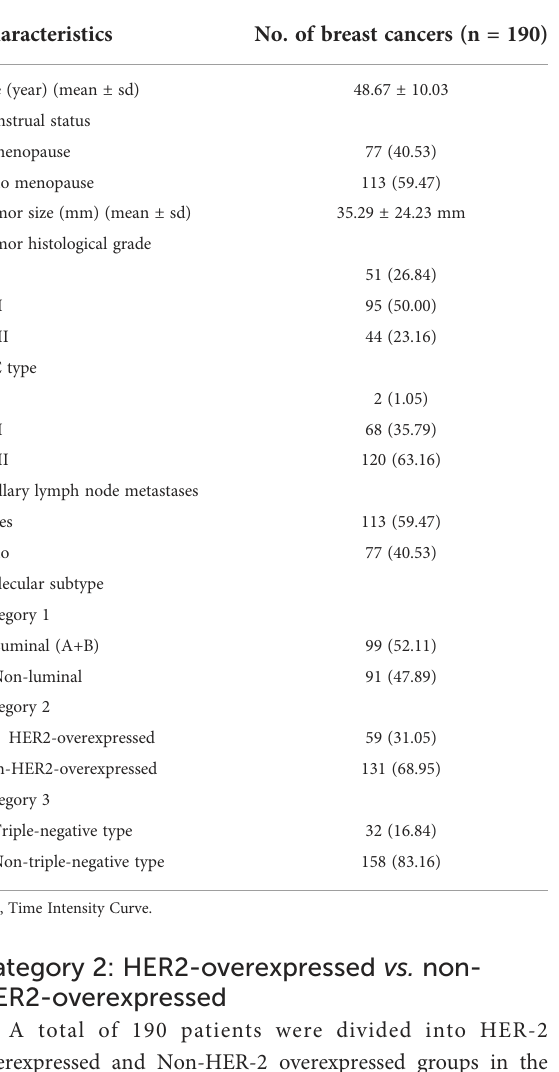
TABLE 1 Tumor characteristics.